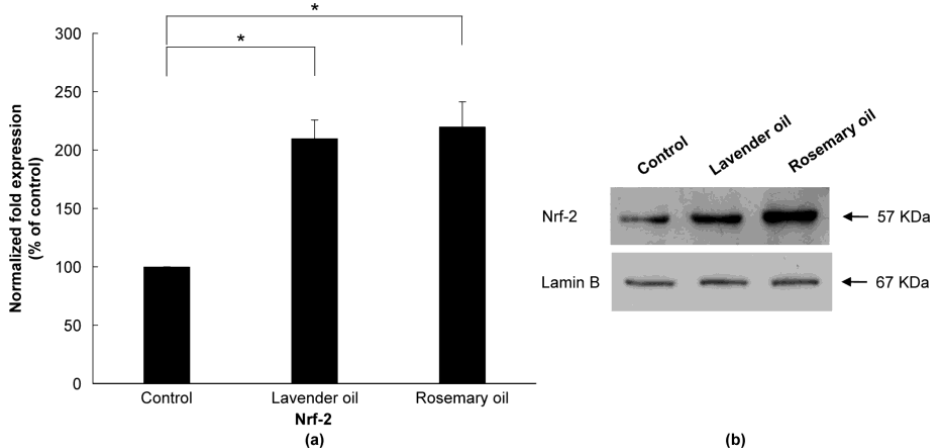
Figure 7. Upregulation of NRF-2 by lavender (0.01%) and rosemary (0.01%) oils in the 3D-DPC culture system. To confirm the results of the 2D-DPCs culture system, cells were treated with essential oils in the 3D-DPC culture system. ( a ) NRF-2 mRNA levels are qRT-PCR experiments. * p < 0.01 between the essential oils-treated samples and non-treated control DPCs. ( b ) NRF-2 protein expression was analyzed by Western immunoblots.